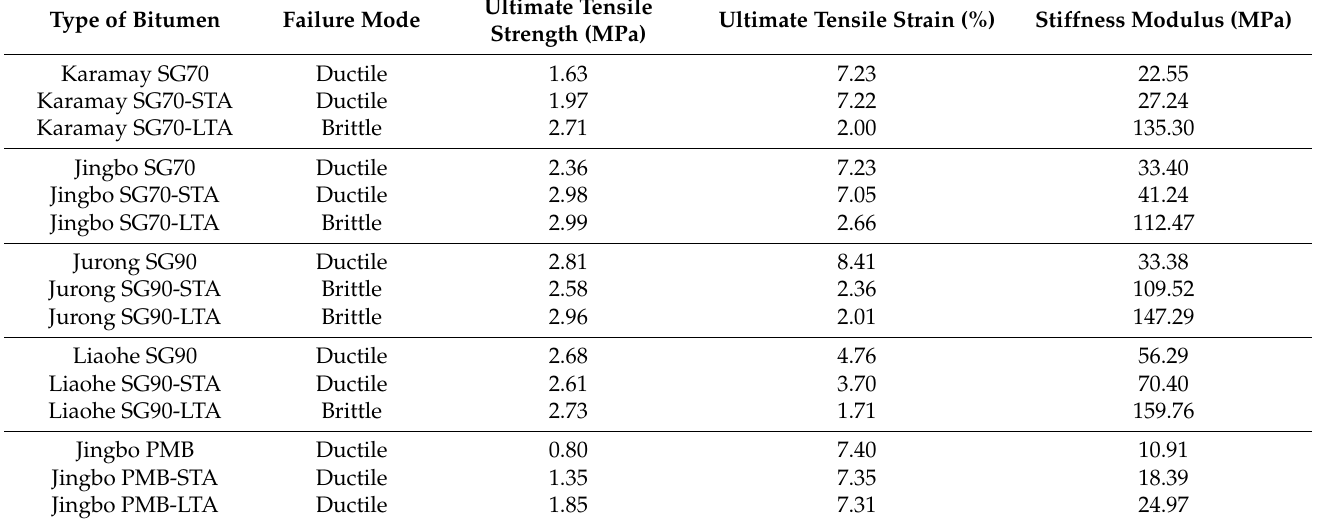
Table 10. Direct tensile test results at − 15 ◦ C.